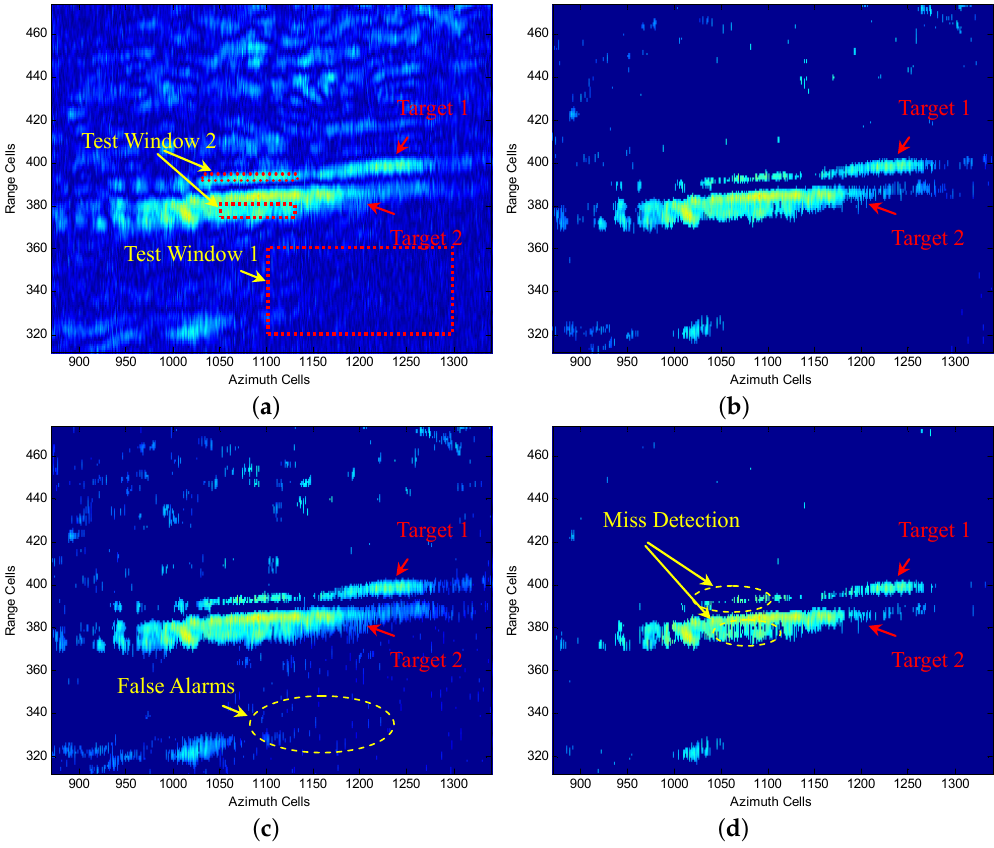
Figure 18. Performance comparison of FOD-CFAR, SO-CFAR and CMLD on the chosen scene: ( a ) Zoom-in view of Target 1 and Target 2; ( b ) FOD-CFAR detection result; ( c ) SO-CFAR detection result; ( b ) CMLD detection